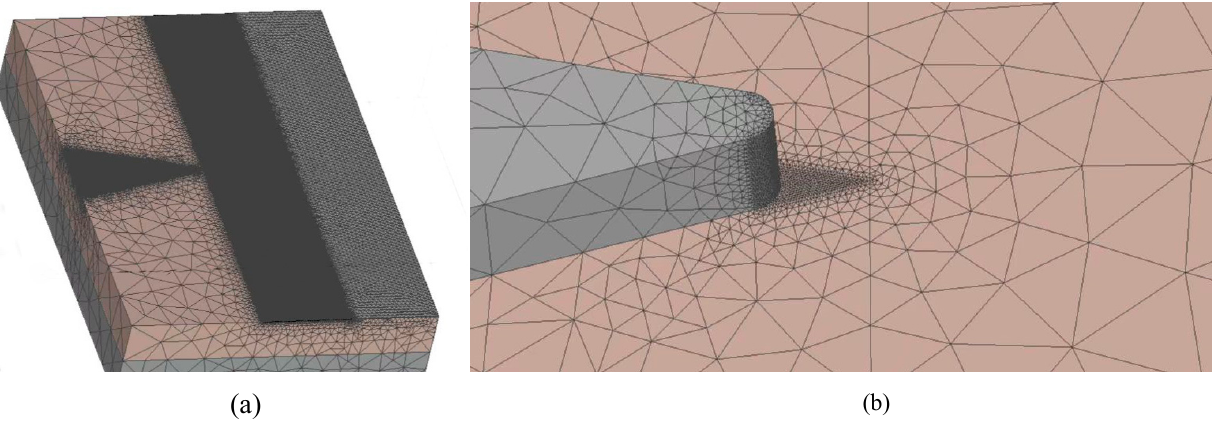
Figure 17. Simulation modeling of the needle-plate electrode. ( a ) The modeling of the needle-plate electrode. ( b ) A local zoomed view of the needle.